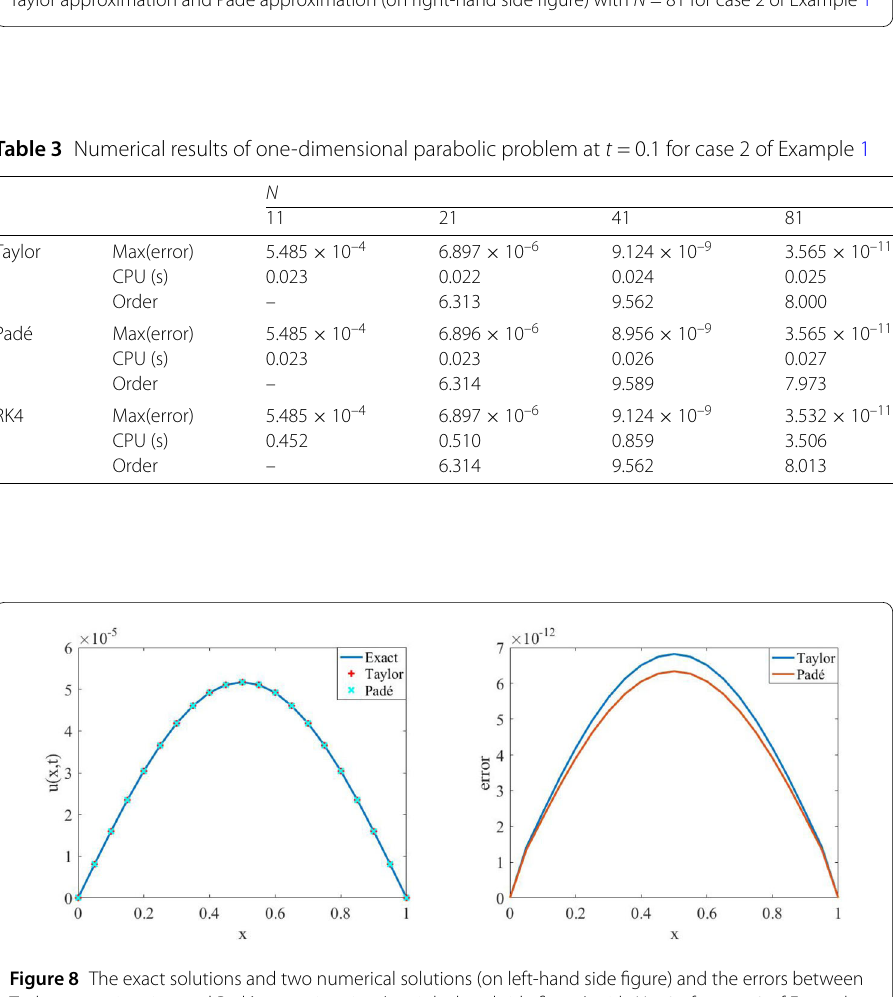
Figure 7 The exact solutions and two numerical solutions (on left-hand side figure) and the errors between Taylor approximation and Padé approximation (on right-hand side figure) with N = 81 for case 2 of Example 1